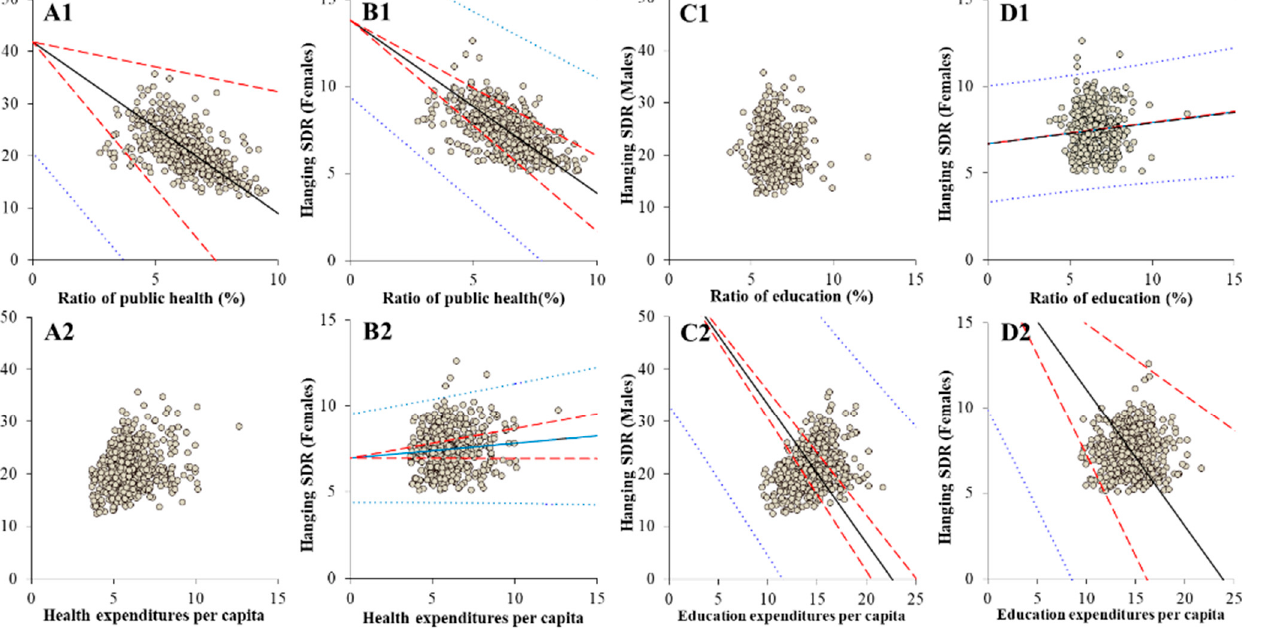
Figure 3. Correlation between expenditures of public health and education of ratio per total amount regional financial expenditure (upper panels: ( A1 – D1) ) and per capita (lower panes: ( A2 – D2) ), and suicide mortality of males and during 2009–2018 using fixed- or random-effect analysis of hierarchal linear regression with robust standard error. Ordinates indicate death rates for suicide mortality based on Japanese age-dependent population composition in 2009 (SDR) of males and females per 100,000 population. Abscissas in upper panels ( A1 – D1 ) indicate the ration of amounts of financial expenditures of public health ( A1,B1 ) and education ( C1 , D1 ) per total amount of regional governmental expenditures (%). Abscissas in lower panels ( A2 – D2 ) indicate the expenditures of public health ( A2 , B2 ) and education ( C2 , D2 ) per capita (JPY 10,000). Black, red and blue lines indicate the significant slope of fixed effects, standard deviation of fixed effects and fixed effects with random effects, respectively.